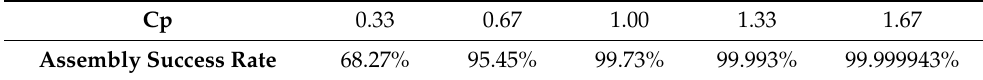
Table 2. Corresponding relationship between Cp and assembly success rate.